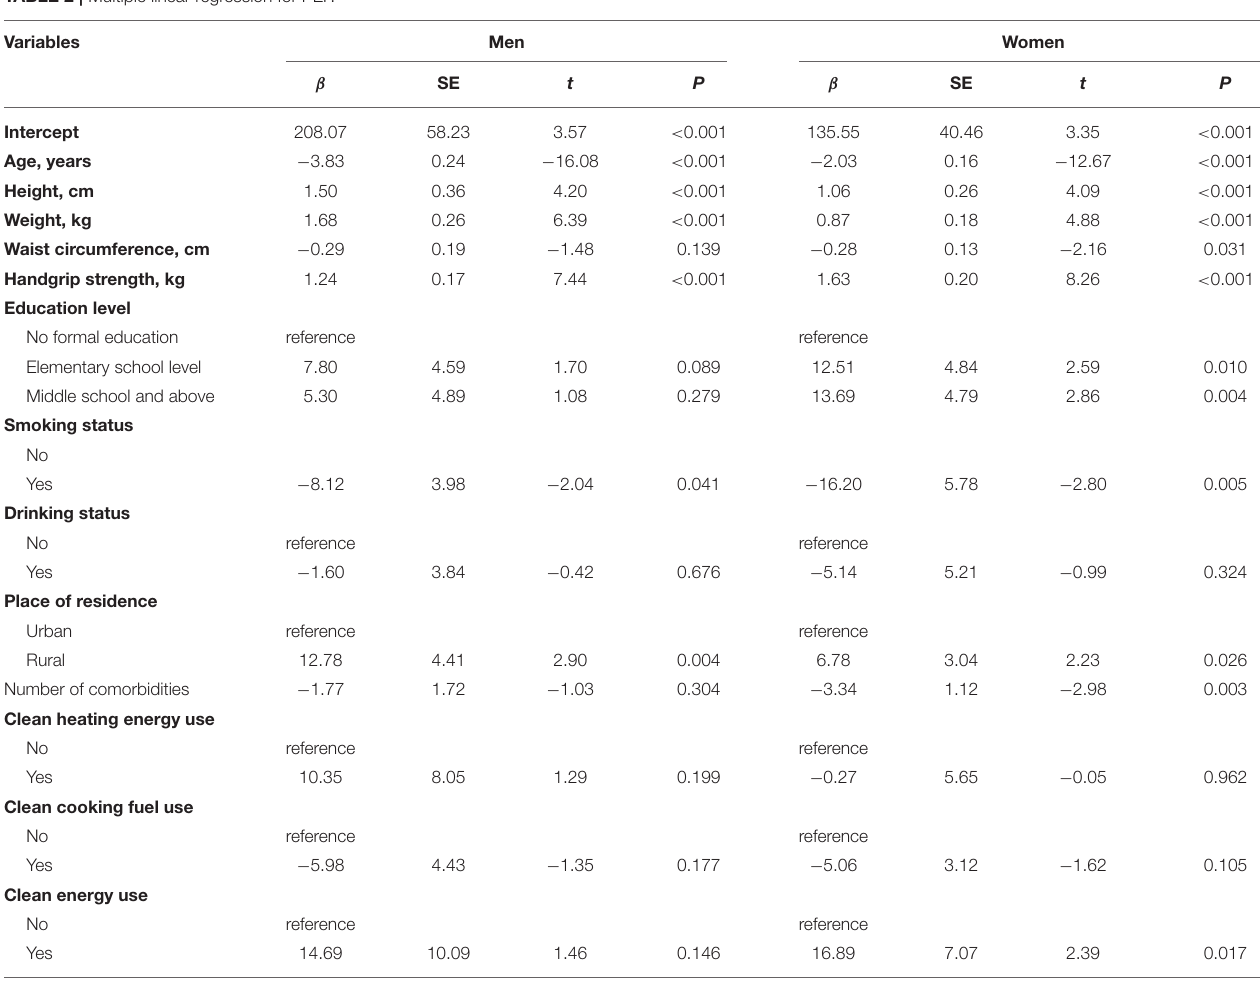
TABLE 2 | Multiple linear regression for PEF.